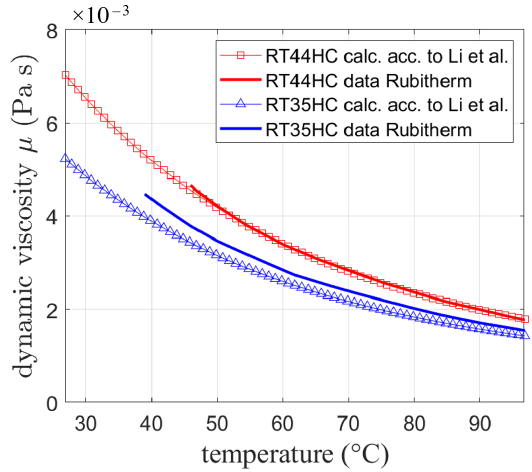
Figure 3. Dynamic viscosity calculated by Equation (22) based on [33] compared to data from Rubitherm